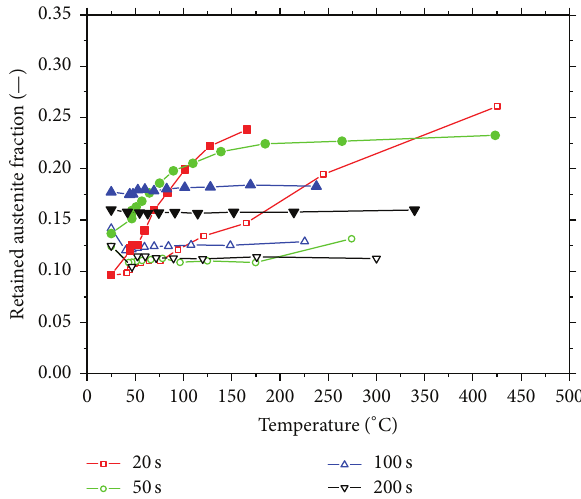
Figure 8: The change in the austenite fraction during quenching, implying the stability in austenite after different time during bainitic transformation at 450 ∘